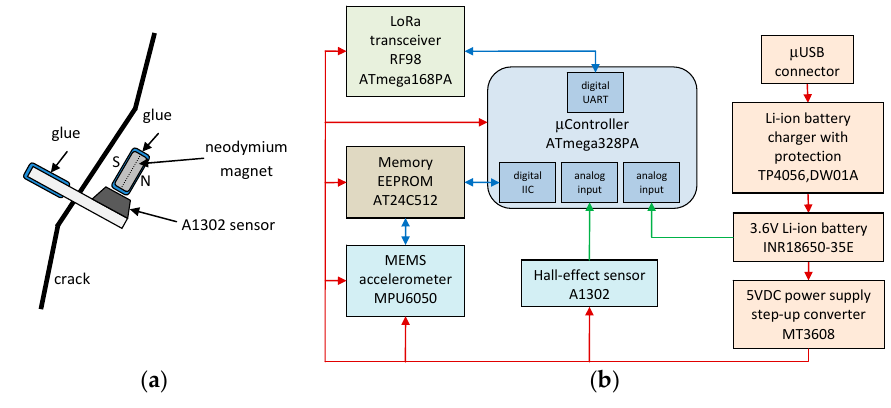
Figure 4. Sensing node: ( a ) Hall-effect sensor configuration; ( b ) Node schematic diagram (red arrows—power lines, blue arrows—data lines, green arrows—analog signal lines).